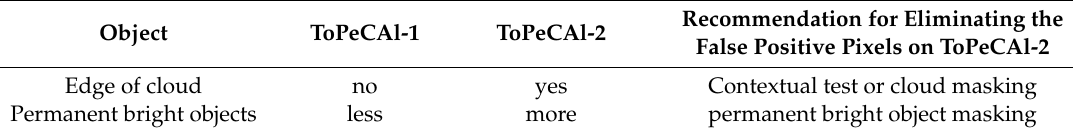
Table 5. Visual comparison on false positive fire pixels of ToPeCAl with SWIR and TIR (ToPeCAl-1) and ToPeCAl without TIR (ToPeCAl-2) applied to Landsat-8 images.